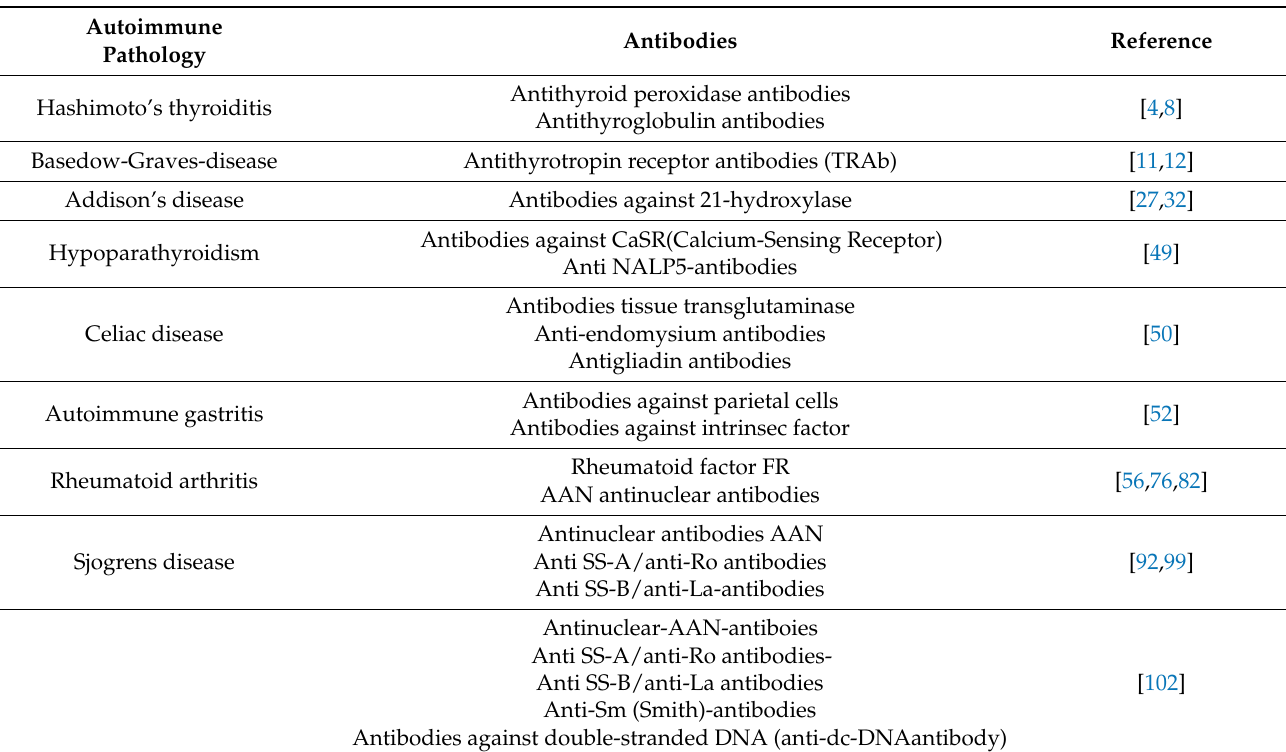
Table 1. The autoimmune diseases and corresponding antibodies [4,8,11,12,27,32,49,50,52,56,76,82,